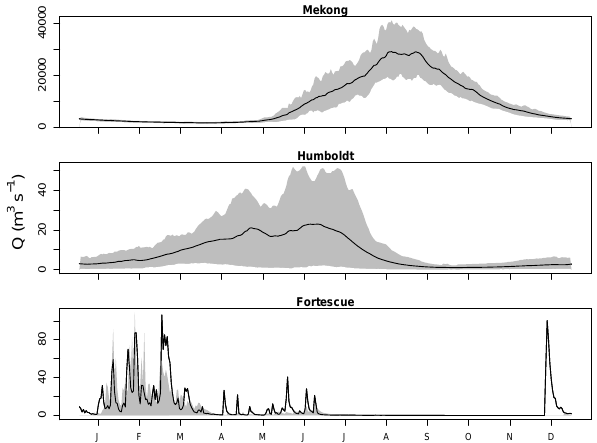
Fig. A2. Yearly regimes of the additional rivers based on average daily discharge (black line) and the spread between the 10th and 90th percentile values (gray zone).